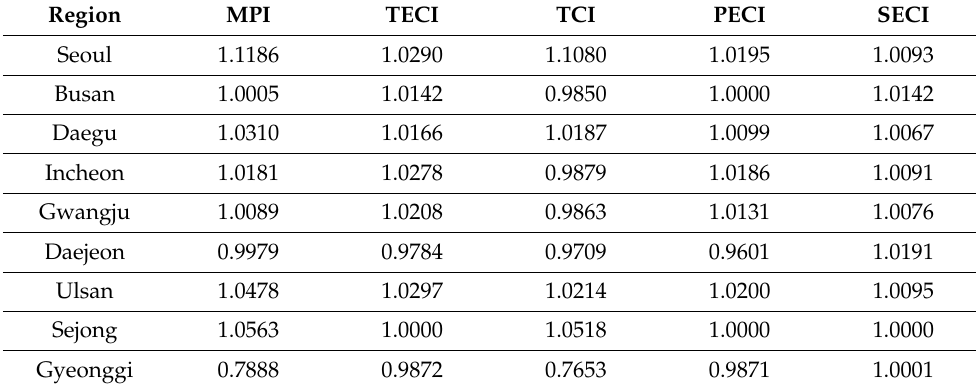
Table 6. Malmquist productivity index and component change